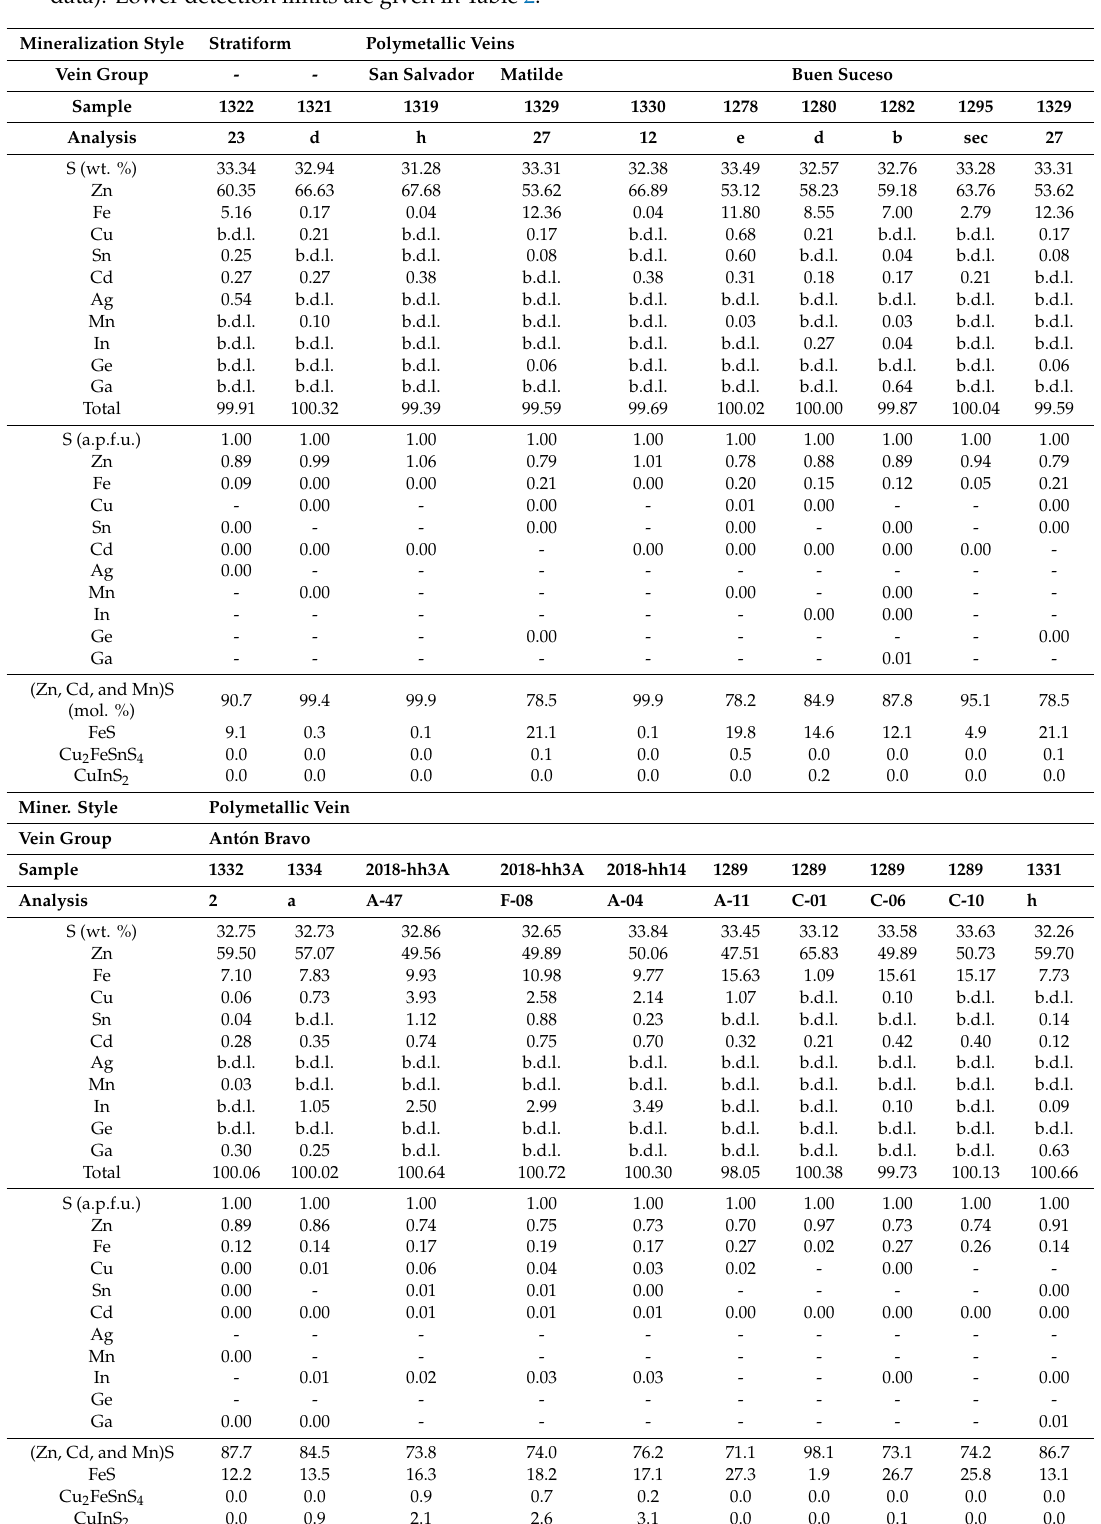
Table 3. Representative analyses of sphalerite crystals from the Huari Huari district, including chemical composition, structural formulas normalized to S = 1, and molecular composition (electron-microprobe data). Lower detection limits are given in Table